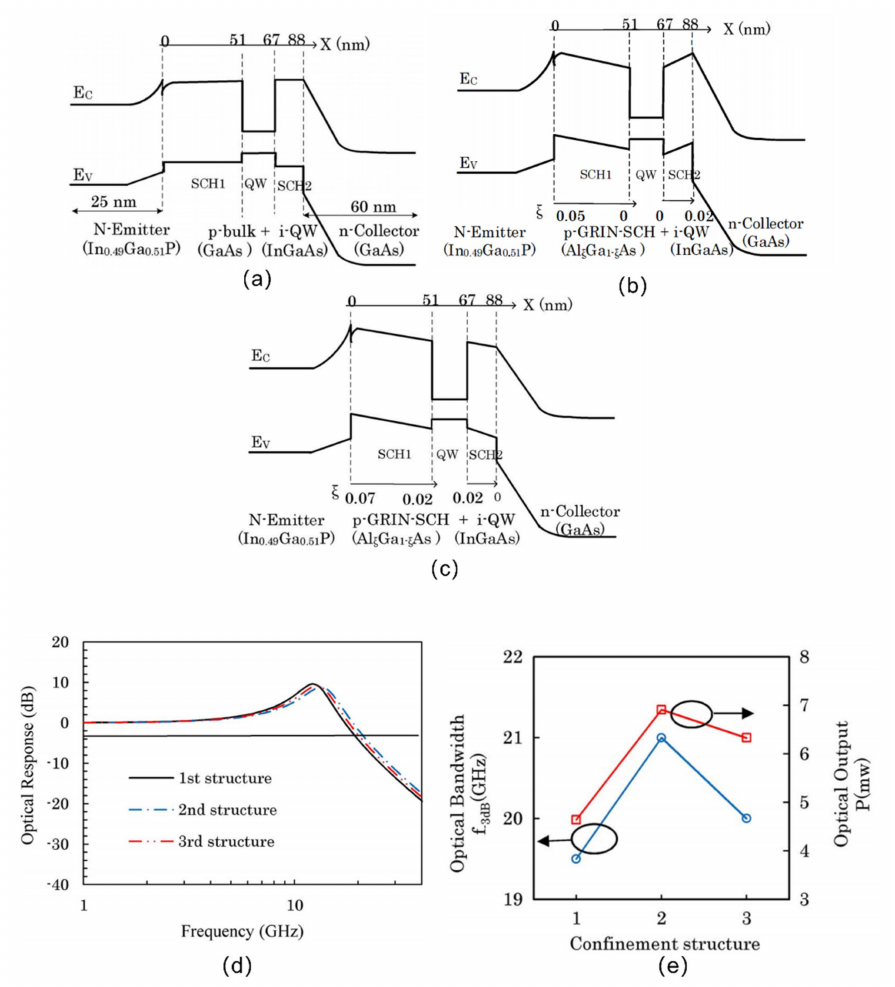
Figure 8. ( a ) First TL band structure proposed by Feng et al., i.e., Structure (1) [52]. ( b ) First introduced GRIN-SCH structure, i.e., Structure (2) [52]. ( c ) Second introduced GRIN-SCH structure, i.e., Structure (3) [52]. ( d ) Frequency response curve of TL corresponding to Structure (1), (2), and (3) [52]. ( e ) Optical bandwidth and output power of each structure